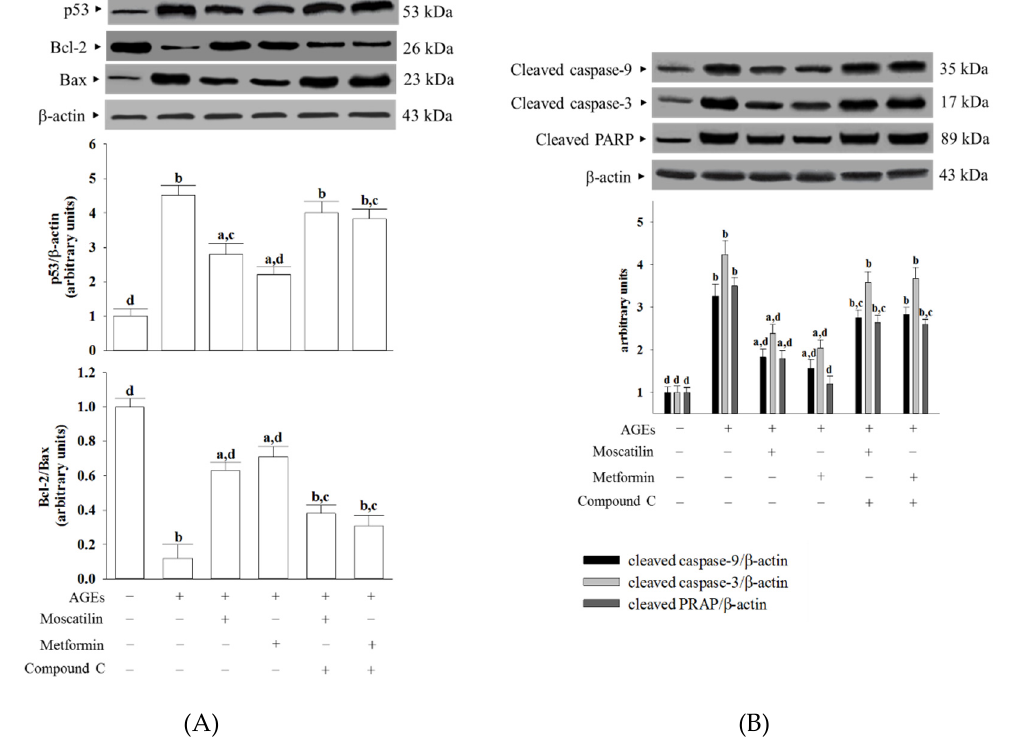
Figure 4. E ff ects on the pro-apoptotic and anti-apoptotic proteins in AGEs-treated SH-SY5Y cells. Cells were pretreated with moscatilin (1 µ mol / L) or metformin (2 µ mol / L) for 1 h, followed by exposure to 50 µ g / mL AGEs for another 24 h. Compound C (5 µ mol / L) was added 1 h before moscatilin or metformin were stimulated. The photographs are representative Western blots for ( A ) p53, Bcl-2 and Bax, ( B ) cleaved caspase-3 and PARP. The densities of protein bands were quantitated and shown in the bottom panels. The results are presented as the mean ± SD of five independent experiments ( n = 5), each of which was performed in triplicate. a p < 0.05 and b p < 0.01 compared to the data from untreated group (vehicle control). c p < 0.05 and d p < 0.01 when compared to the data from cells cultured under AGEs without any